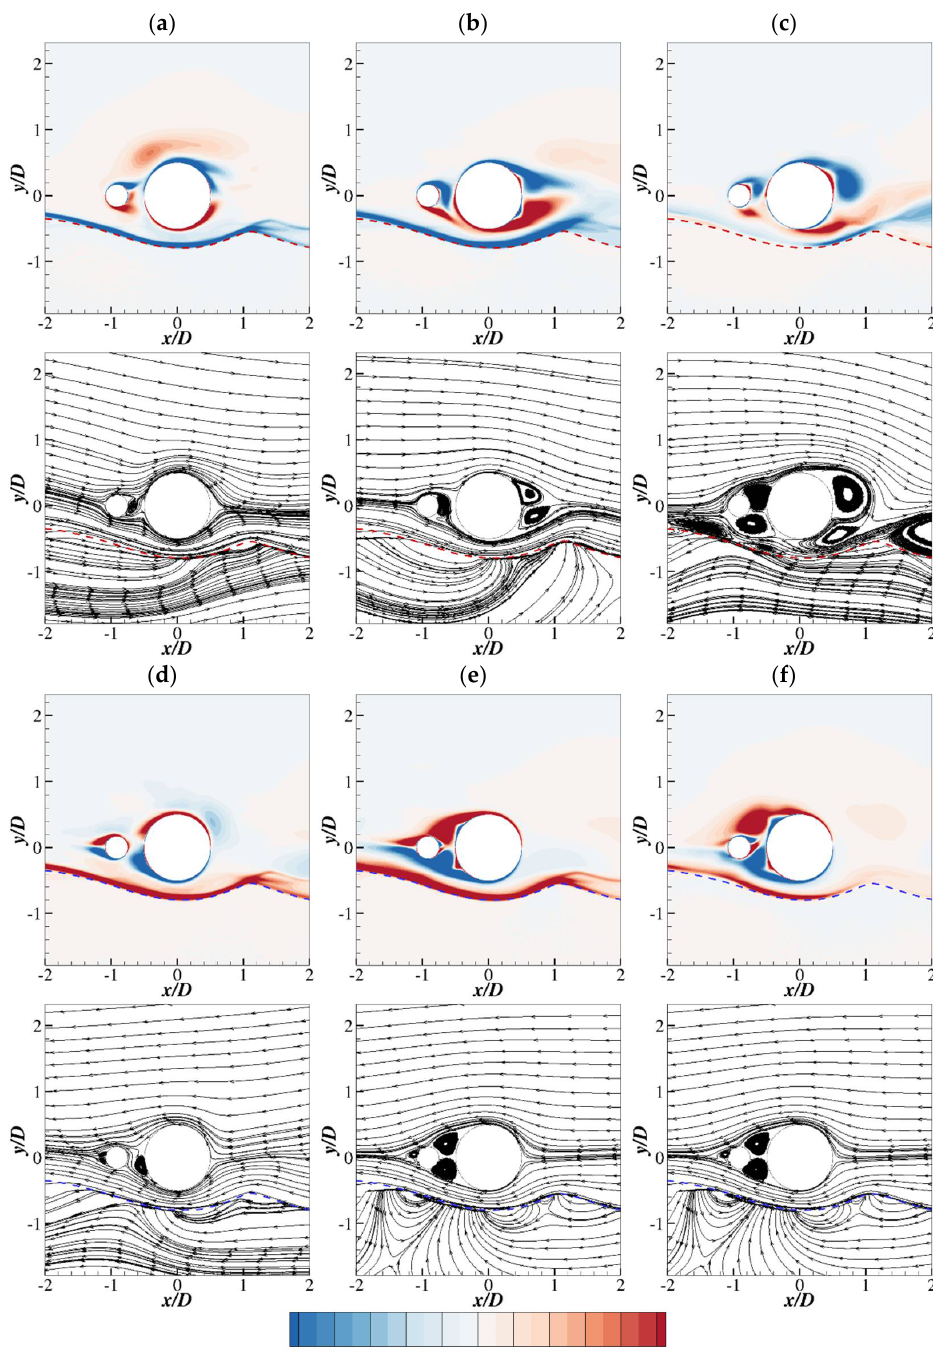
Figure 14. The phase-averaged spanwise vorticity and the streamlines for the piggyback pipeline with α = 0 ◦ at the phase of ( a ) T w /6; ( b ) T w /3; ( c ) T w /2; ( d ) 4 T w /3; ( e ) 5 T w /6; ( f ) T w . The dashed lines denote the iso-surface identified by φ =